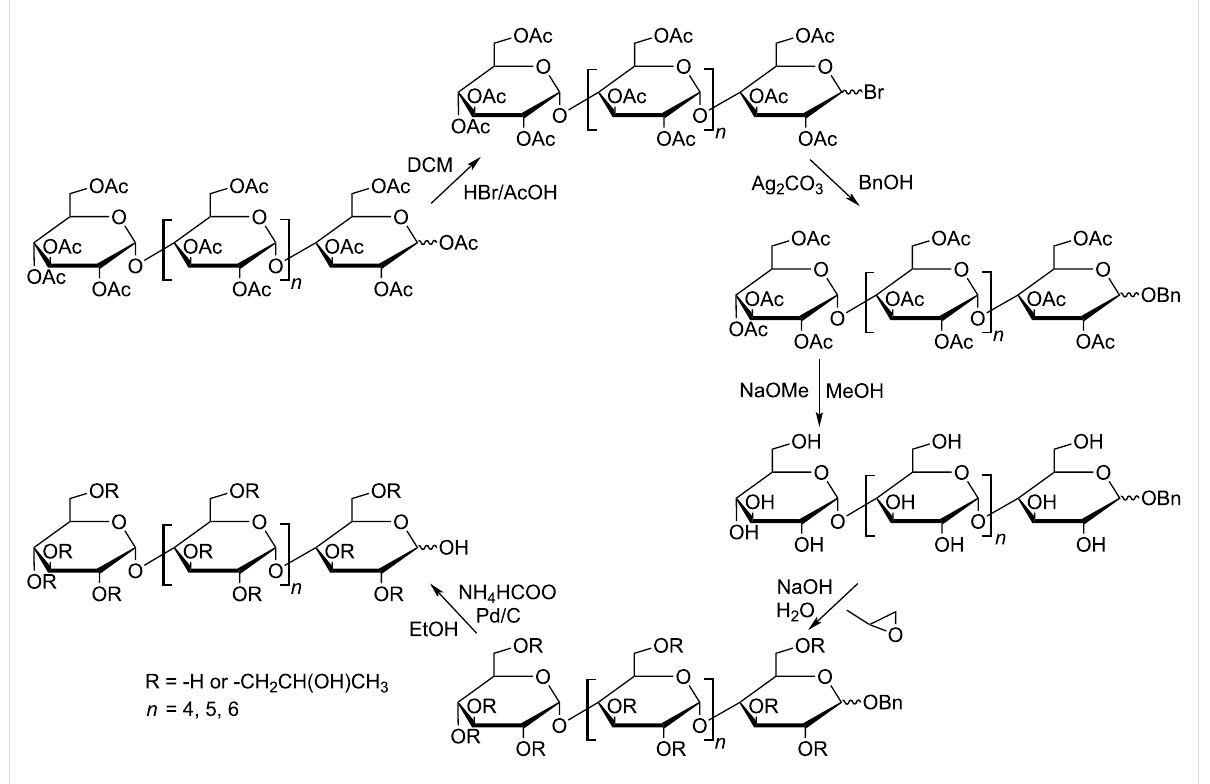
Scheme 1: Schematic representation of the preparation of HP-substituted